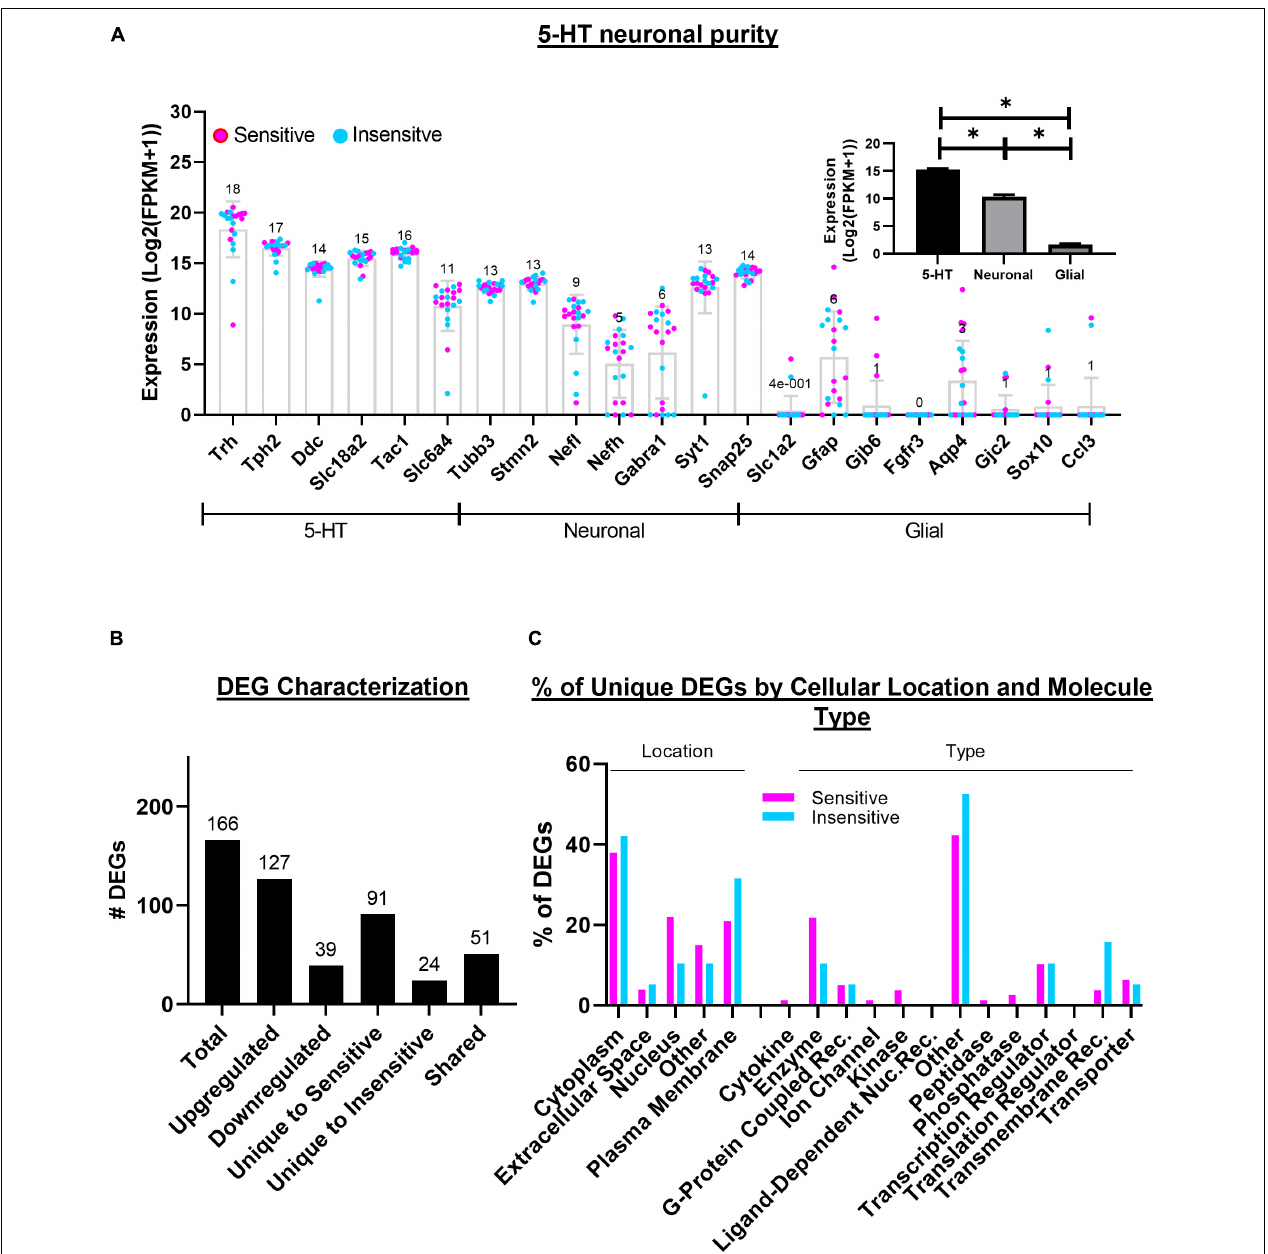
FIGURE 3 | 5-HT neuron RNA sequencing data are highly representative of 5-HT neurons. Expression [Log2(FPKM + 1)] of 5-HT, neuronal, and glial cell markers are indicated for each of the 21 neuron cDNA libraries that were sequenced (A) and 5-HT neuronal purity is statistically significant [ (A) , inset]. Number and characteristics of differentially expressed genes (DEGs) among sequenced cells (B) . Subcellular location and molecular types represented across the 166 DEGs (C) . One-way ANOVA ( P < 0.05) with Sidak’s post hoc tests (A) . ∗ P <